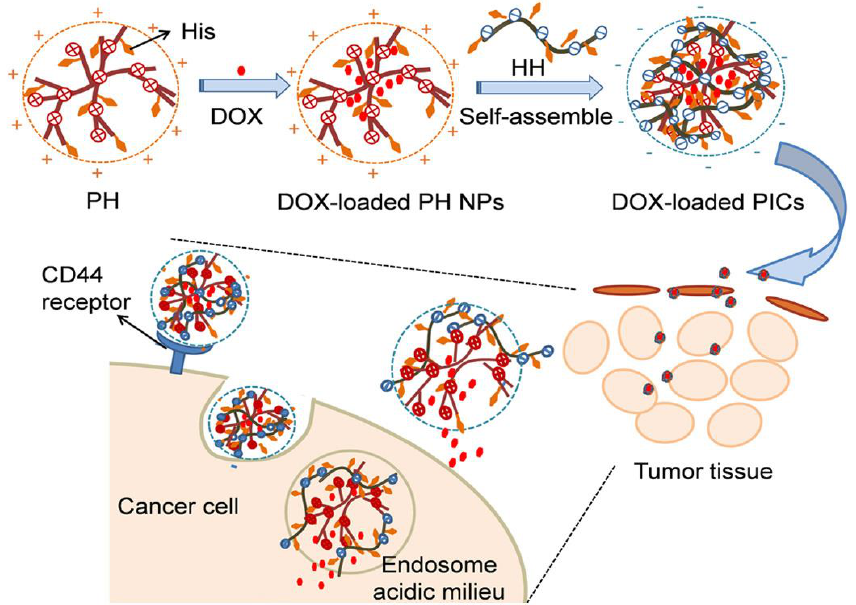
Figure 6. Representation of the synthesis of HH/PH LbL assembly and the pH-controlled targeted drug delivery. Reprinted from [43], with permission from Elsevier.